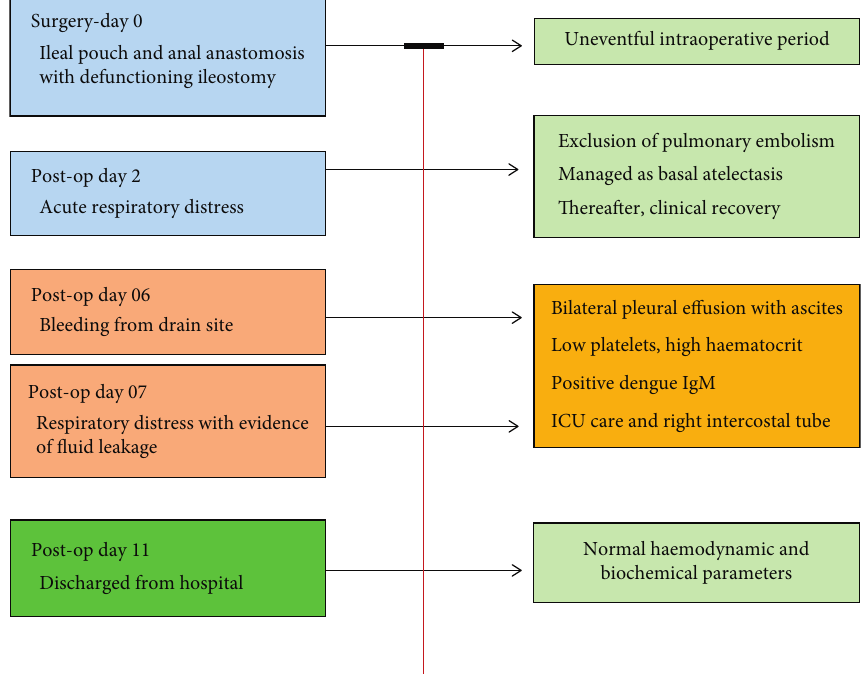
Figure 3: Timeline of key events and